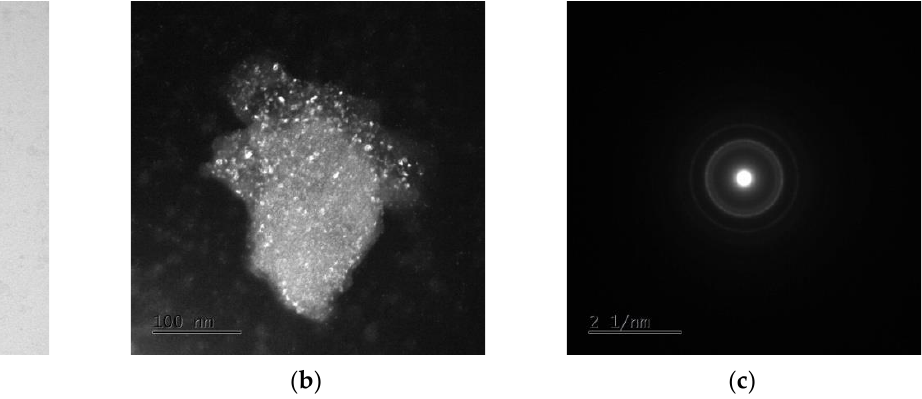
Figure 4. Chemical analysis (EDS) obtained for Mg 65 Zn 30 Ca 4 Ag 1 alloy after 70 h of milling: ( a ) Ana- lyzed area; ( b ) an example of a chemical composition diagram for area 1; ( c ) chemical composition of selected areas (1 and 2).